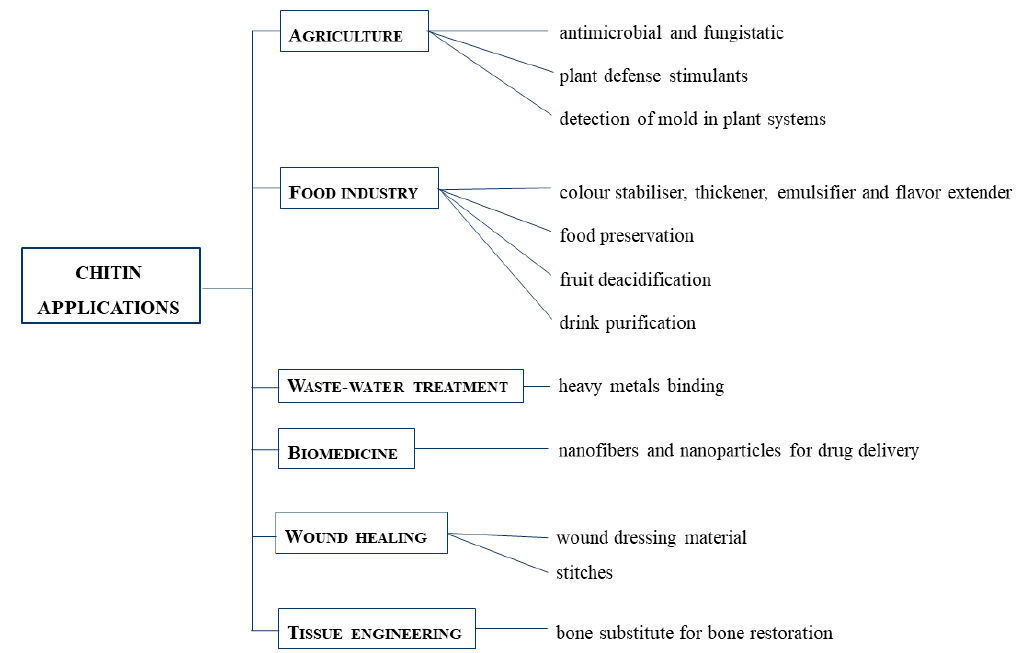
Figure 3. Chitin applications in different fields: agriculture, food industry, waste-water treatment, biomedicine, wound healing and tissue engineering.